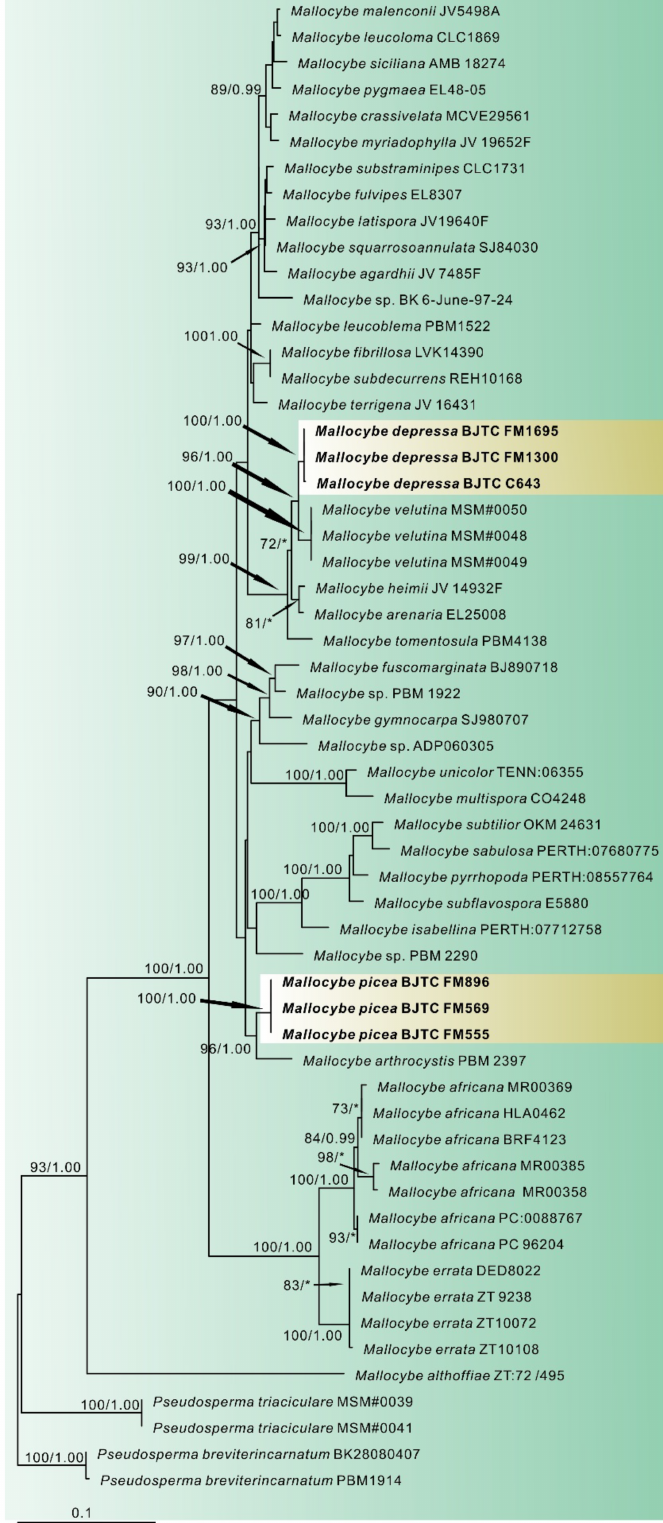
Figure 1. Phylogeny derived from Maximum Likelihood analysis of the combined (ITS/LSU/ rpb2 ) dataset of Mallocybe and related genera in the family Inocybaceae. Pseudosperma triaciculare and P . breviterincarnatum were employed to root the tree as an outgroup. Numbers representing likelihood bootstrap support (BS ≥ 70%, left) and significant Bayesian posterior probability (BPP ≥ 0.99, right) are indicated above the nodes. New sequences are highlighted in black